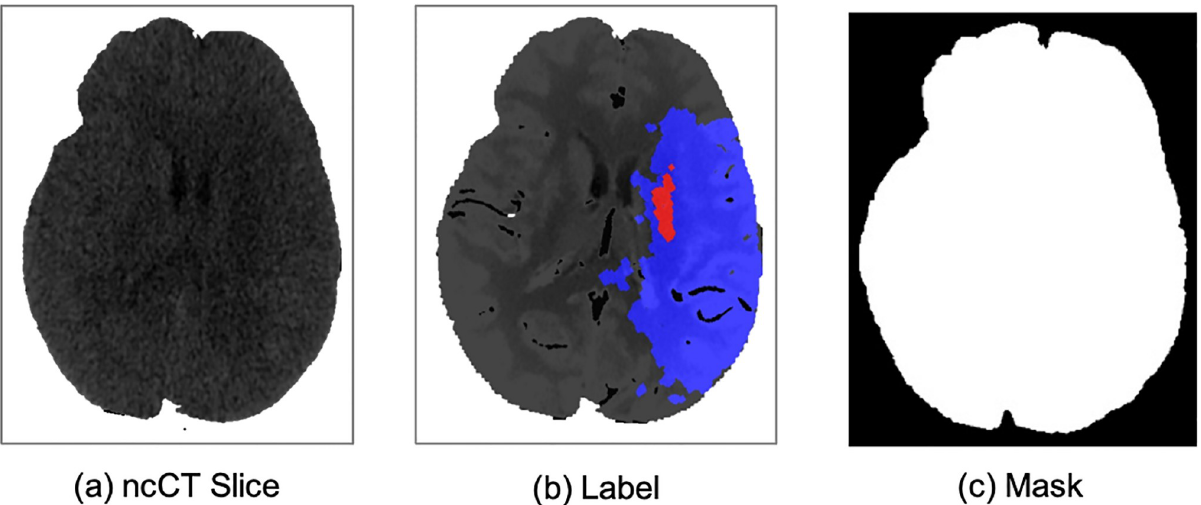
Fig 5. Input for feature extraction (a) brain region on an ncCT slice (b) corresponding CTp, (c) the mask of the brain region. (a) ncCT Slice. (b) Label. (c) Mask.